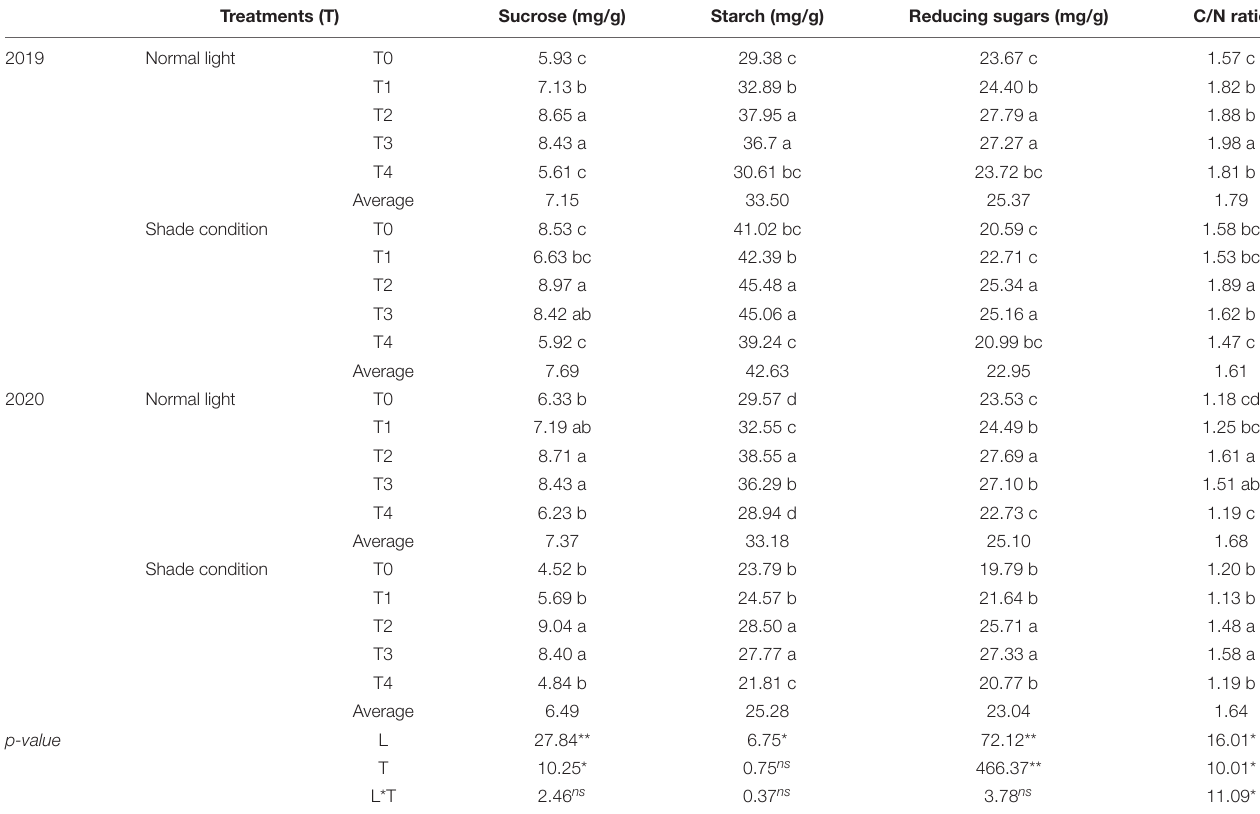
TABLE 1 | Effect of varied NH 4 + /NO 3 − ratios on total carbohydrates and C/N ratios under different light conditions. Treatments